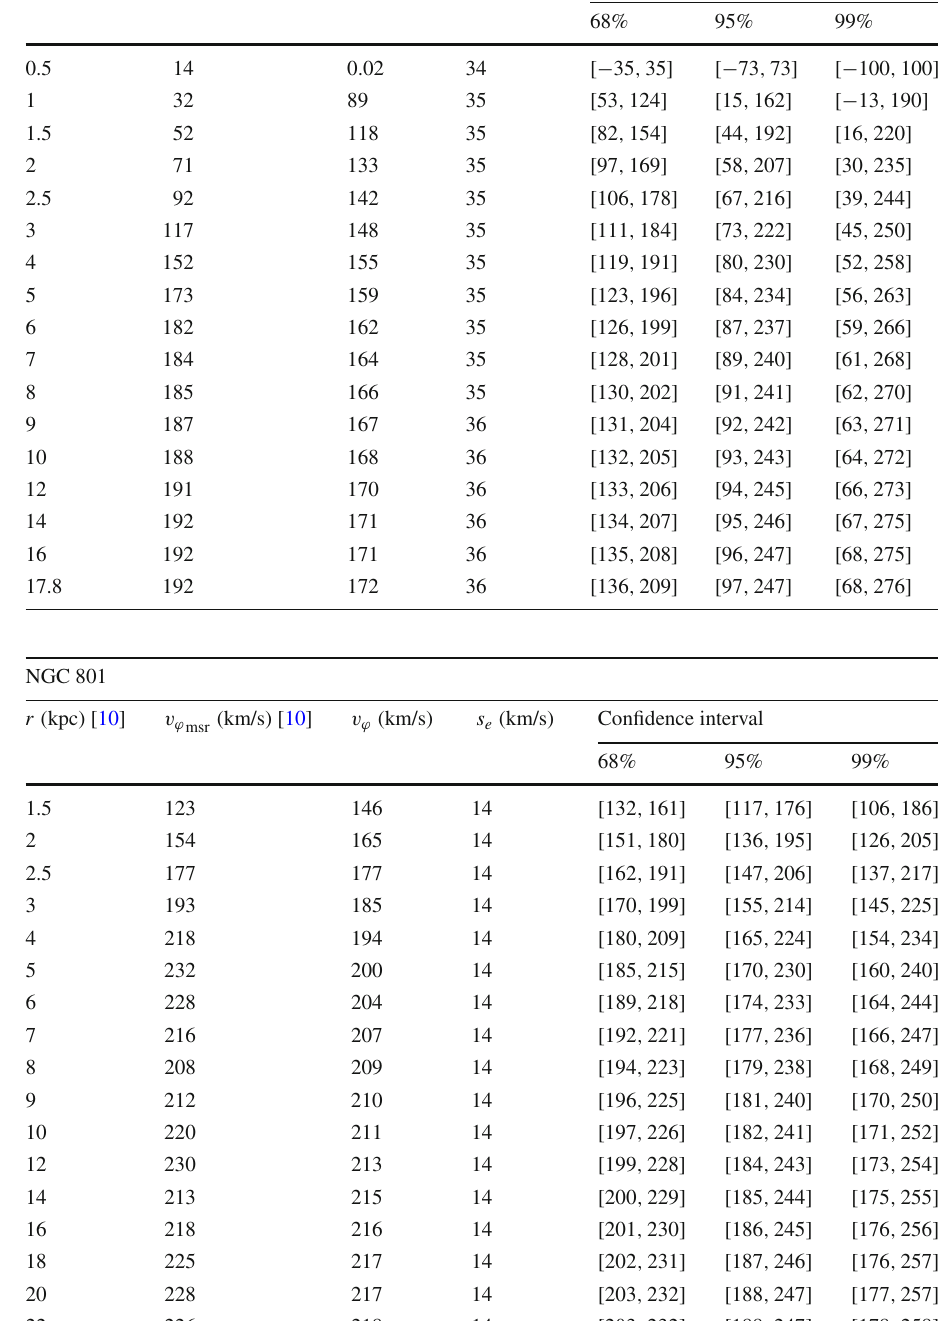
calculated velocities, standard errors and confidence intervals for the NGC 3672 galaxy